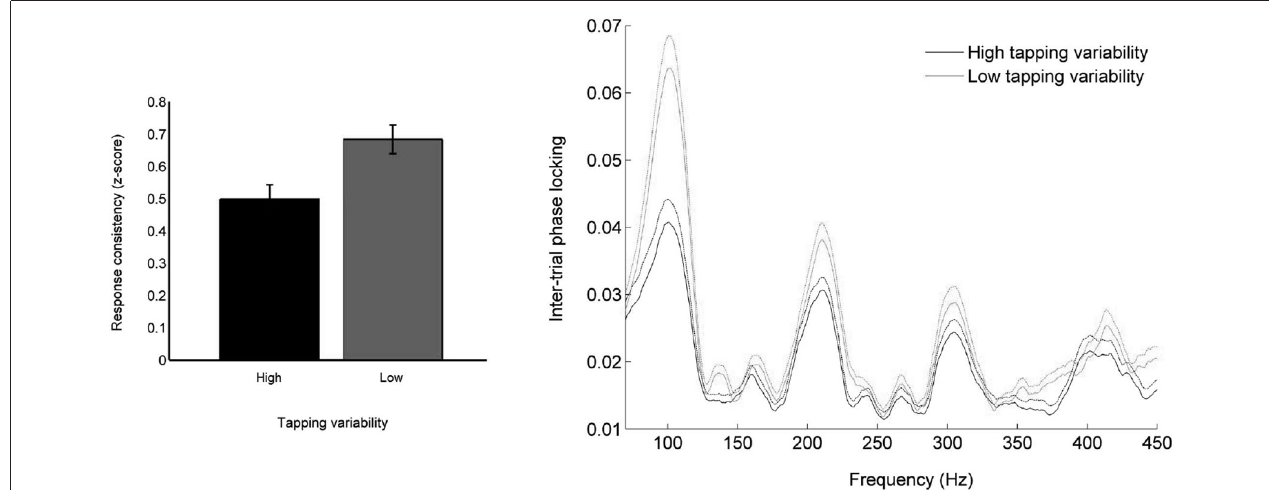
that are jittered less in time from trial to trial. Temporal jitter was measured by calculating frequency-by-frequency phase consistency across all trials (Tierney and Kraus,